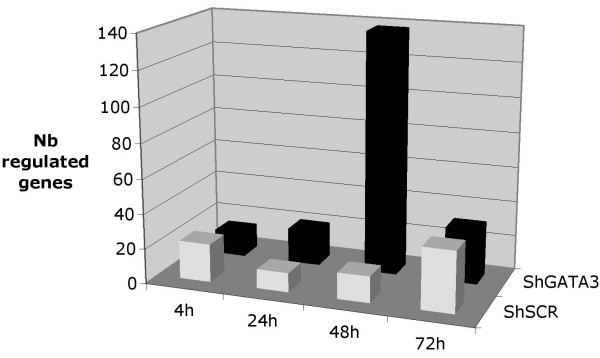
Gene modulation at individual time points in shGATA3 and shSCR transduced cells.